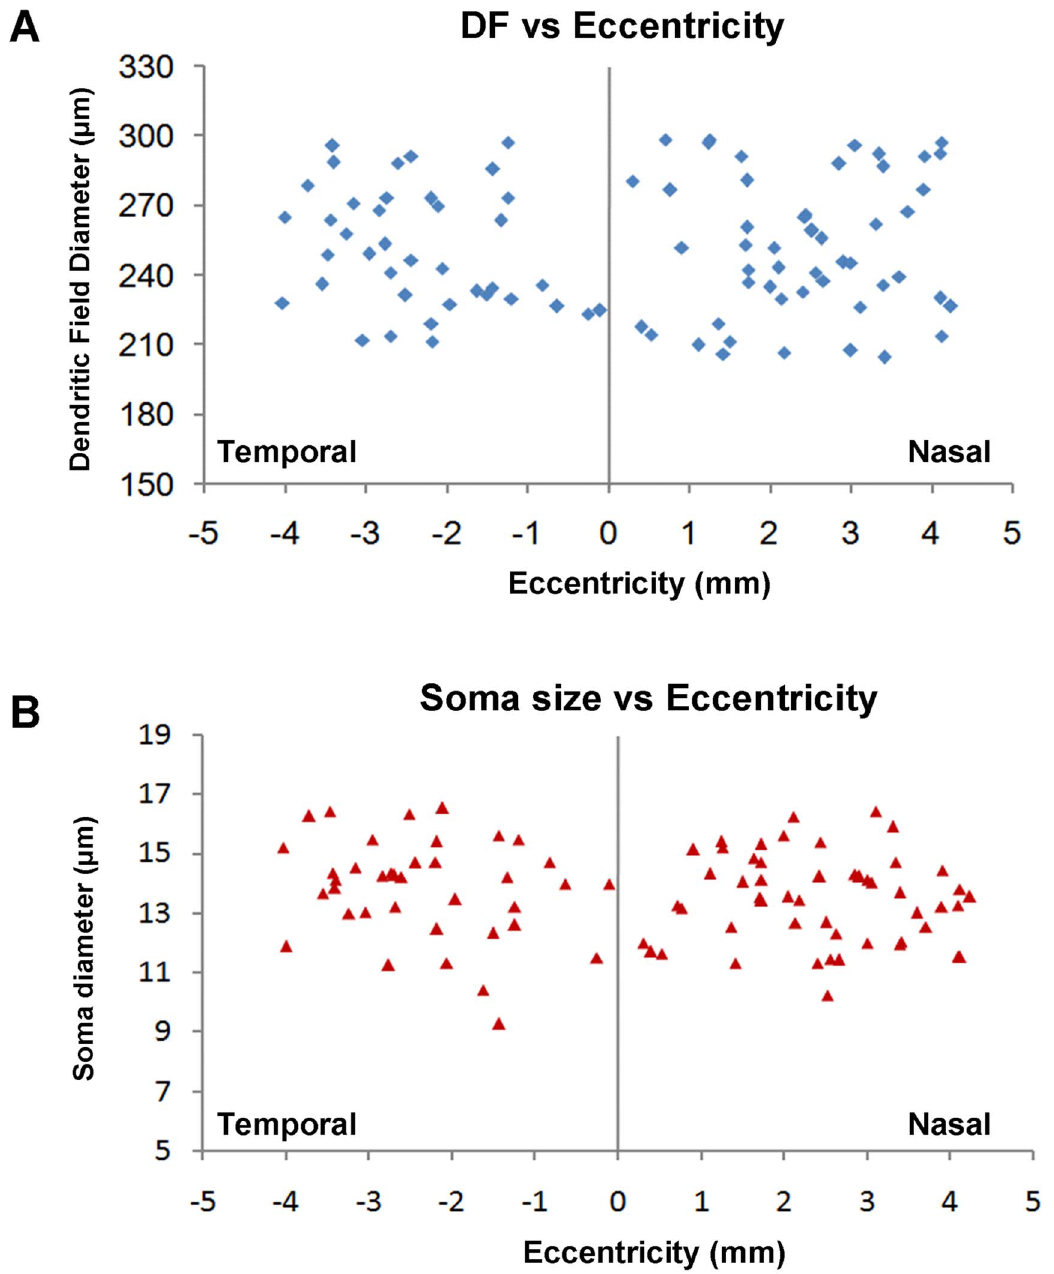
Figure 8. Variation in the sizes of dendritic fields and somata with retinal eccentricity. (A) Plot of dendritic field diameter as a function of eccentricity. (B) Plot of soma diameter as a function of eccentricity. 7 animals were used in each analysis.